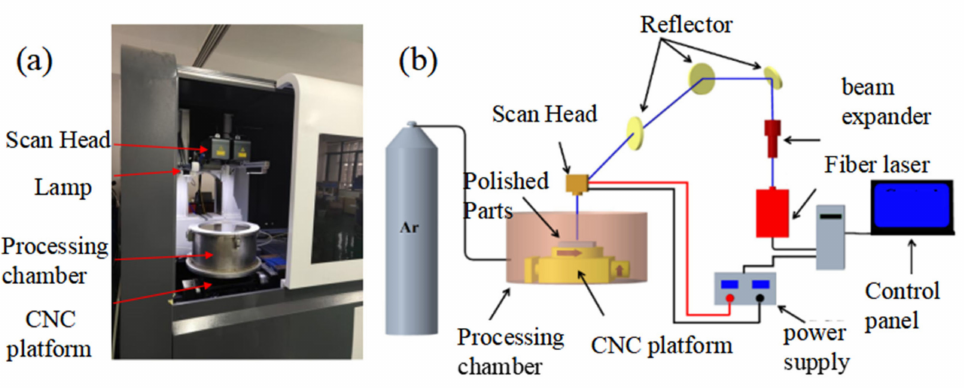
Figure 1. Laser polishing test equipment and schematic diagram: ( a ) test device ( b ) principle of test